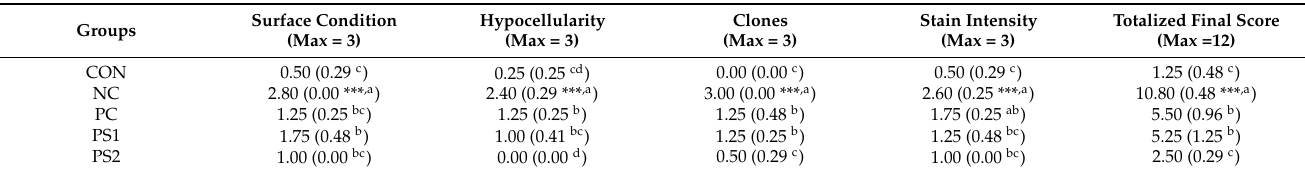
the knee joint tissues of OA